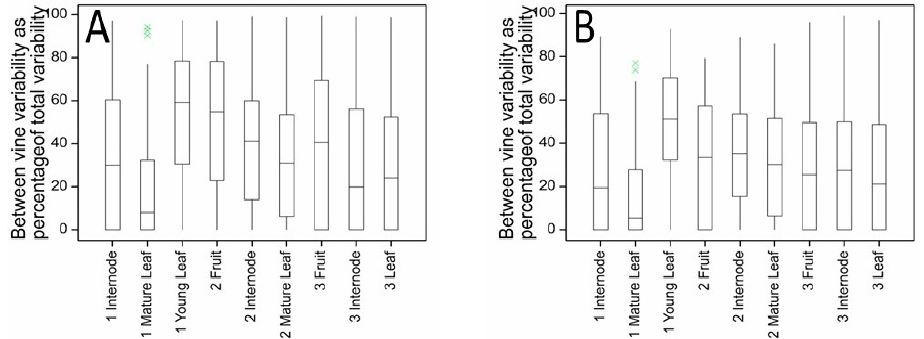
Figure 5. Between-vine (inter-vine) variability as a percentage of total variability for kiwifruit metabolites measured in fruit, internode and leaf tissues of ‘Zesy002’ kiwifruit by LC-MS at three harvest times showing distributions of percentage variances for ( A ) all metabolites and ( B ) for only those metabolites with CV <20%.